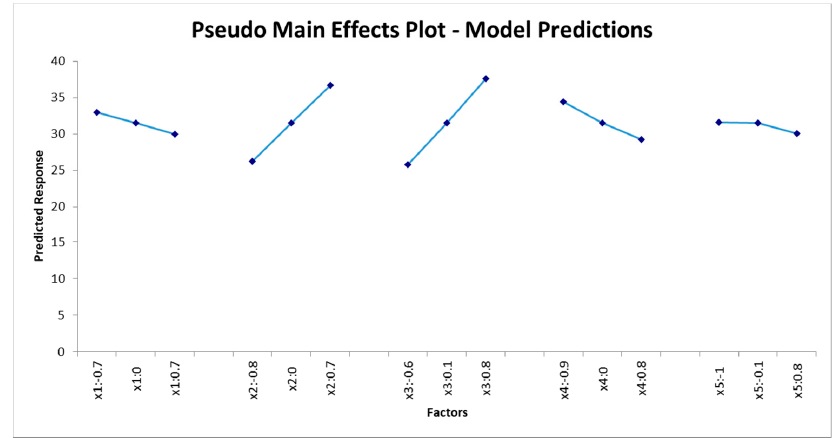
Figure 4. Main effects plot from the simulation experiment.